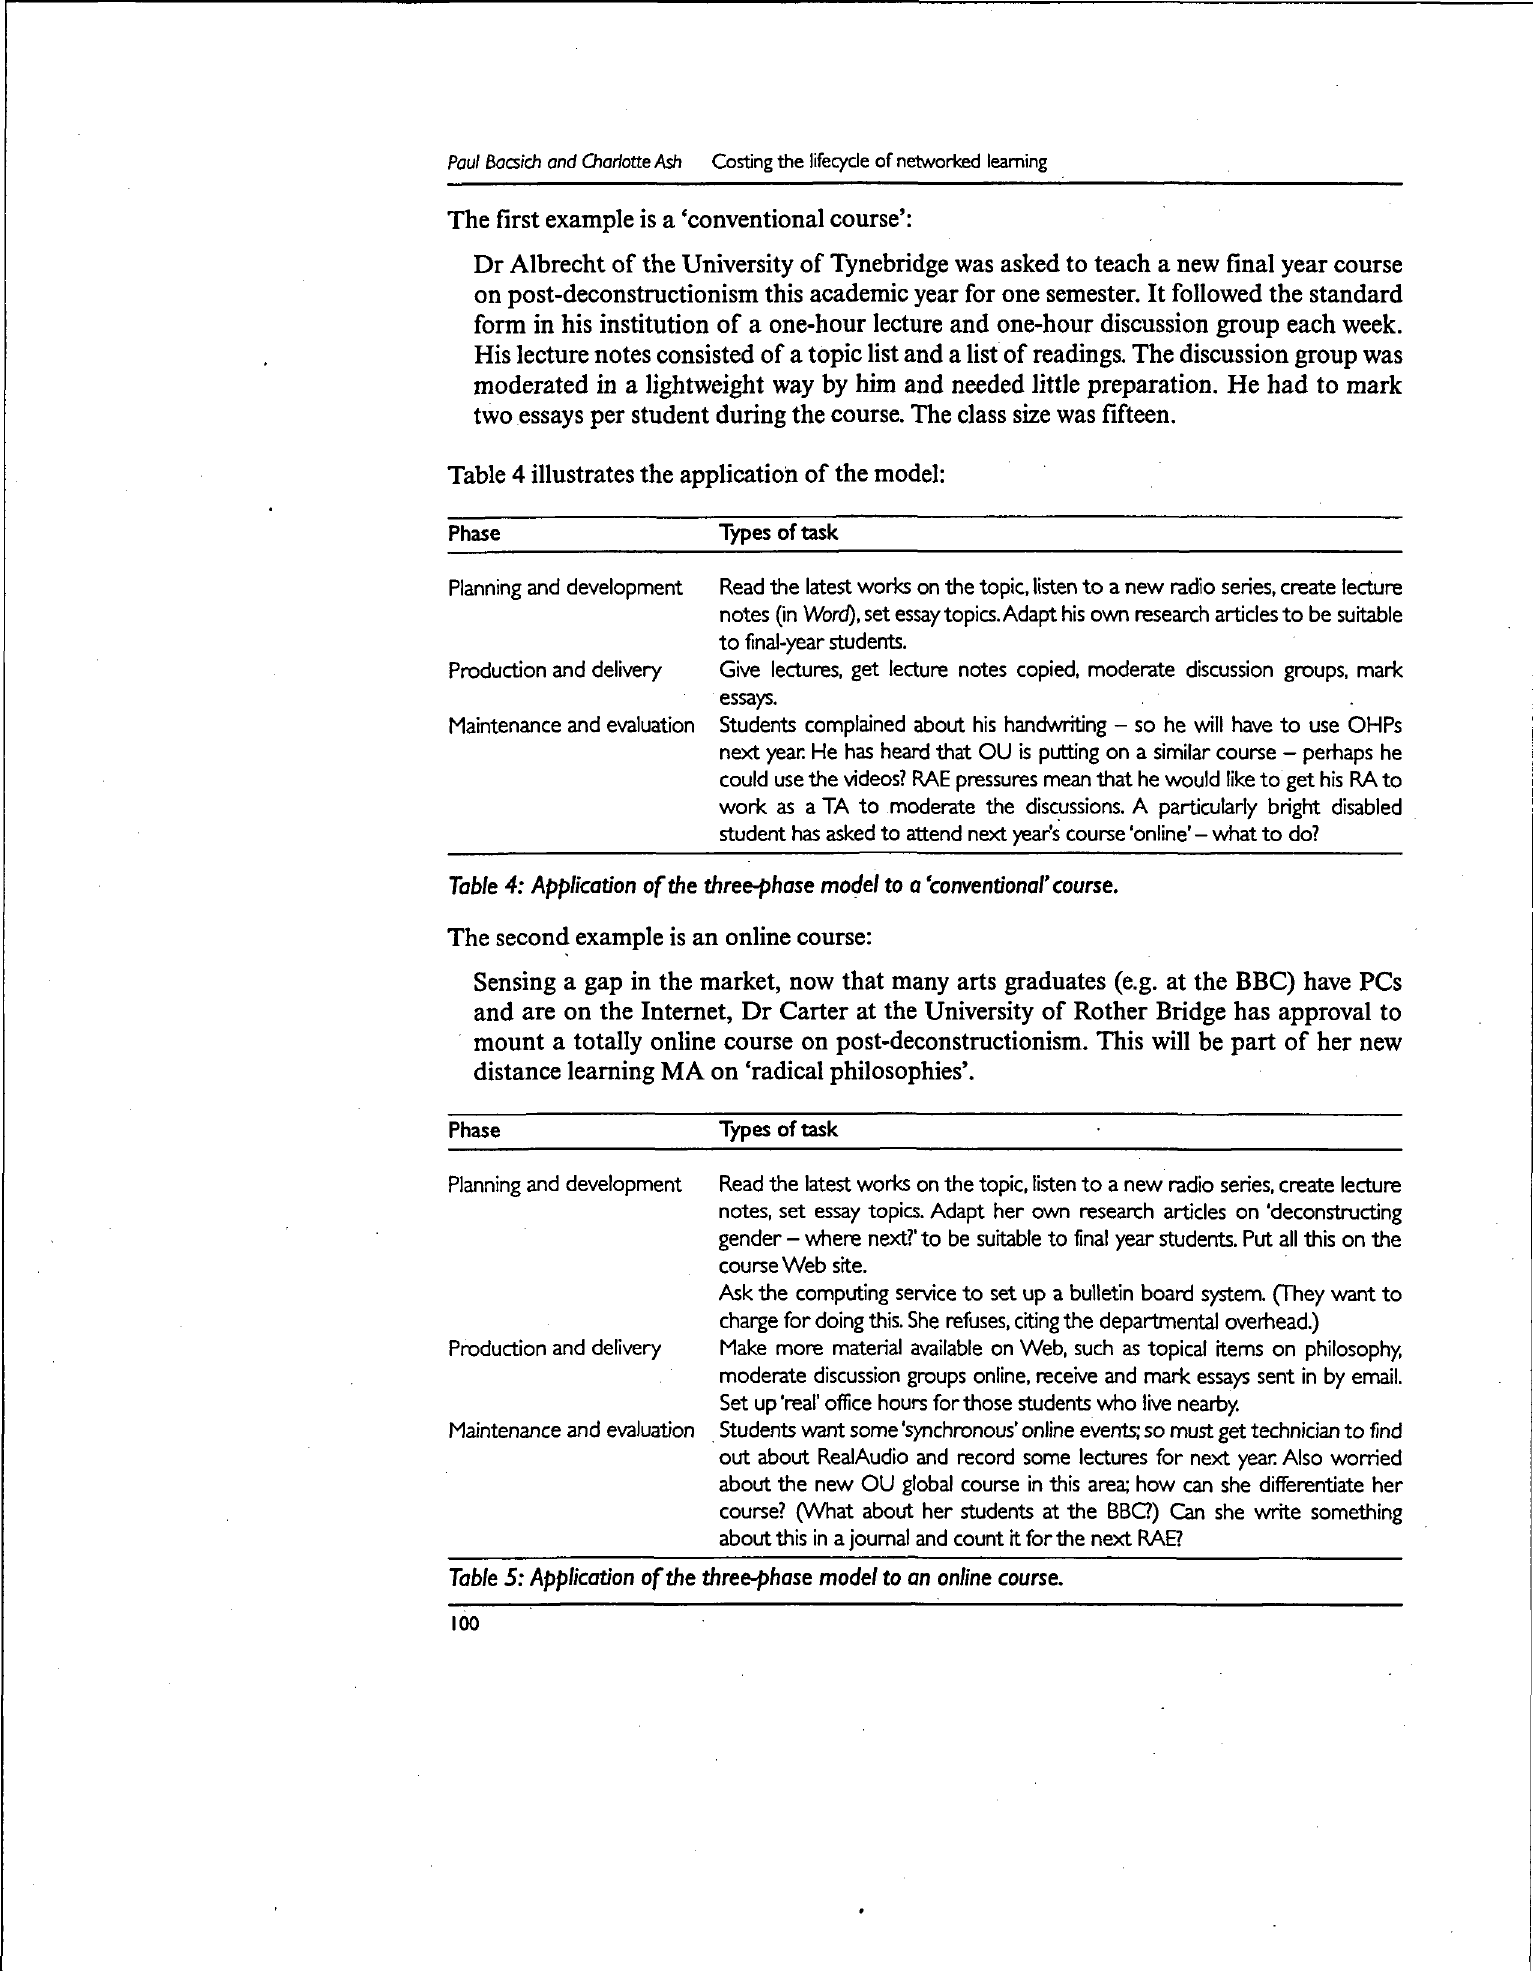
Table 4: Application of the three-phase model to a 'conventional'course.